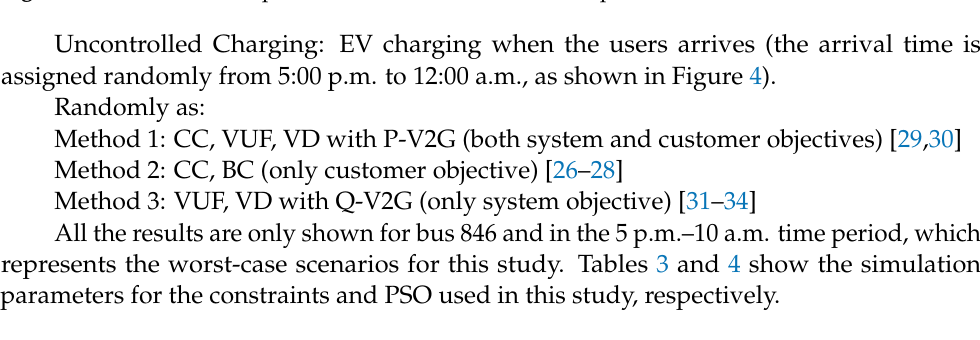
Table 3. Simulation parameters for